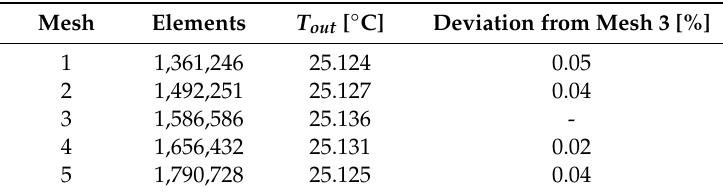
Table 3. Mesh independence check.